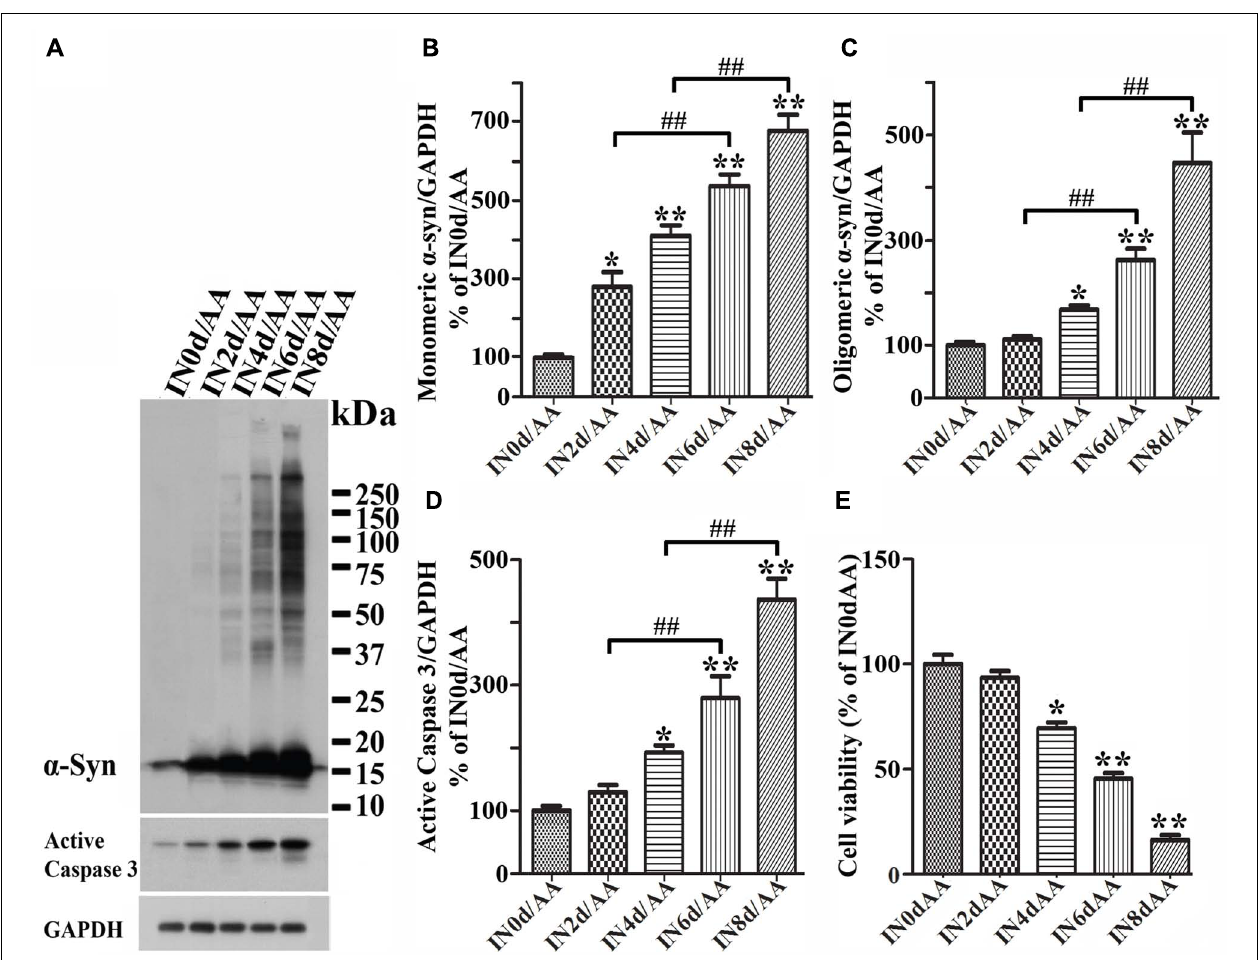
additional experiments.The average values of control groups (IN0d/AA) were set as 100%. (E) Calcein assay showed an inverse relationship between cell viability and the duration of α -syn induction in cultures with AA exposure. Significant decrease of cell viability was detected in cultures with 4 days or longer durations of induced α -syn expression plus AA exposure when compared to non-induced counterparts (IN0d/AA).The results are representative of three independent experiments. Error bars represent SEM. The changes of levels of various proteins or cell viability are statistically significant. (* p < 0.05, ** p < 0.01 comparing to INd0/AA; # p < 0.05, ## p < 0.01, comparing subsets linked by